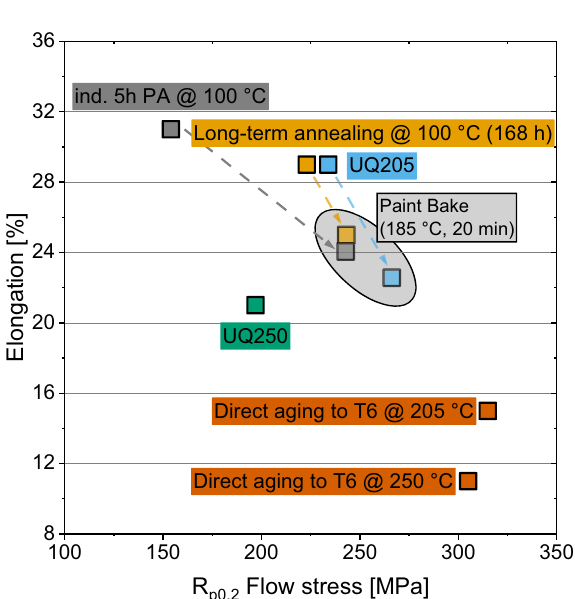
Fig. 8 Comparison of elongation vs. yield strength of the Al – Mg – Si alloy tested after different heat treatments. Direct aging to T6 at 205 and 250 °C generates low elongation values, and UQ250 shows an insuf fi cient combination of low elongation and low strength. Of all the specimens primarily strengthened at 100 °C (ind. 5 h pre-annealing, long-term annealing at 100 °C and UQ205), UQ205 incorporates the greatest strength at comparable elongation values. After industrially typical arti fi cial aging (paint bake, 185 °C, 20 min), indicated by a grey box/dashed arrows for the concerning heat treatment, UQ205 shows the highest strength and elongation Table 1: fraction of solutes in clusters). The Mg- and Si-content of all clusters in relation to their respective Guinier radii is plotted in Fig. 7e. Every dot stands for one measured cluster (note that the total number of atoms measured via APT was different, which explains the higher number of blue data points in Fig. 7e). For both treatments the majority of clusters can be found in the middle of the diagram, indicating an Mg-share of between 0.33